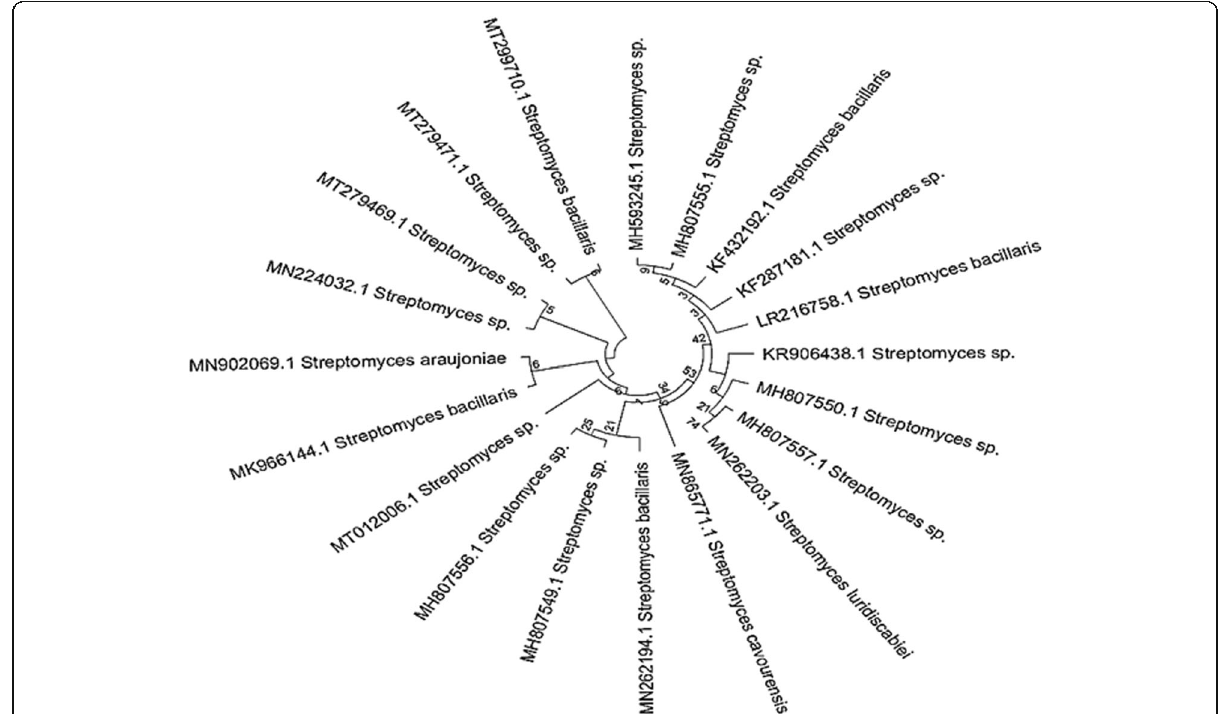
Fig. 1 Phylogram (phylogenetic tree) showing relationships of presumed Streptomyces bacillaris MN262194 based on partial sequencing of the 16S nucleotide sequences with other Streptomyces